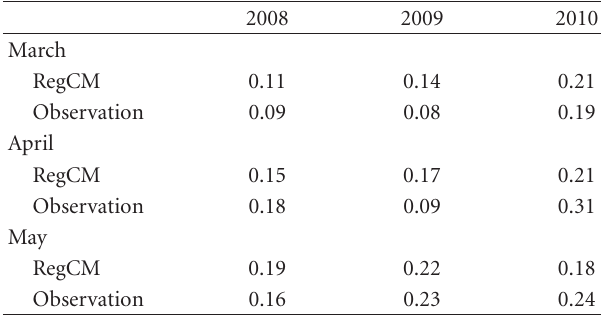
Table 1: Comparison between monthly AOD values (at 500 nm) simulated with the RegCM 4.0 and monthly values observed at the Ragged-point station